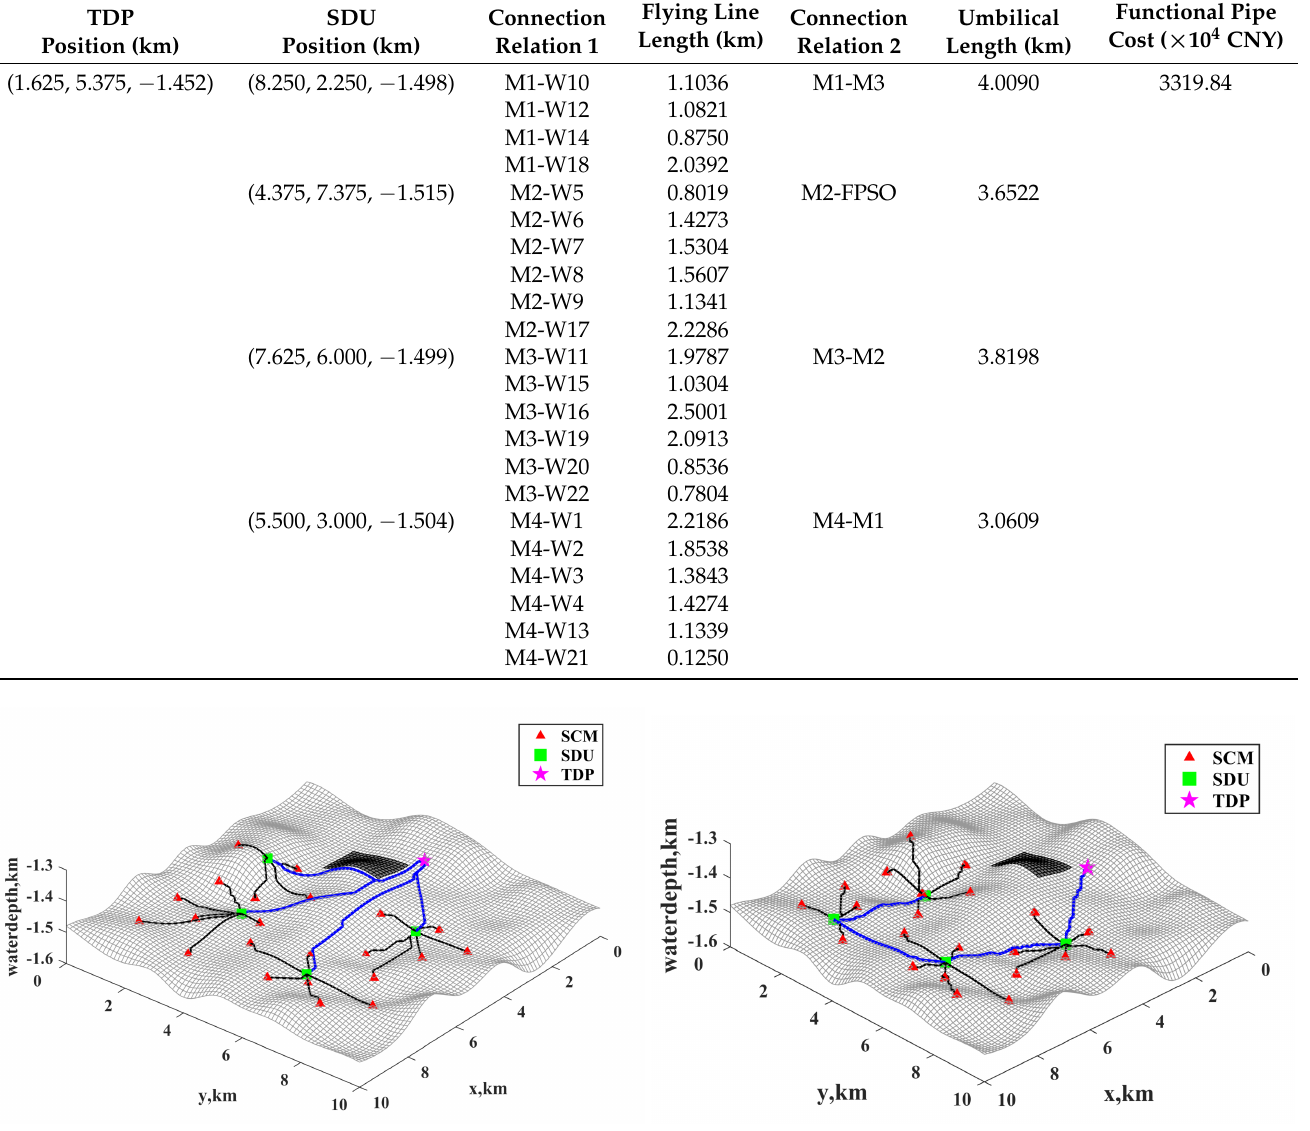
Table 6. The specific information of the optimal layout for the MST layout structure.